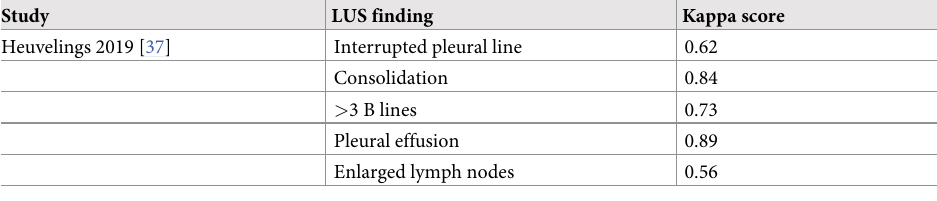
Table 7. Kappa scores for inter-rater reliability of lung ultrasound findings in